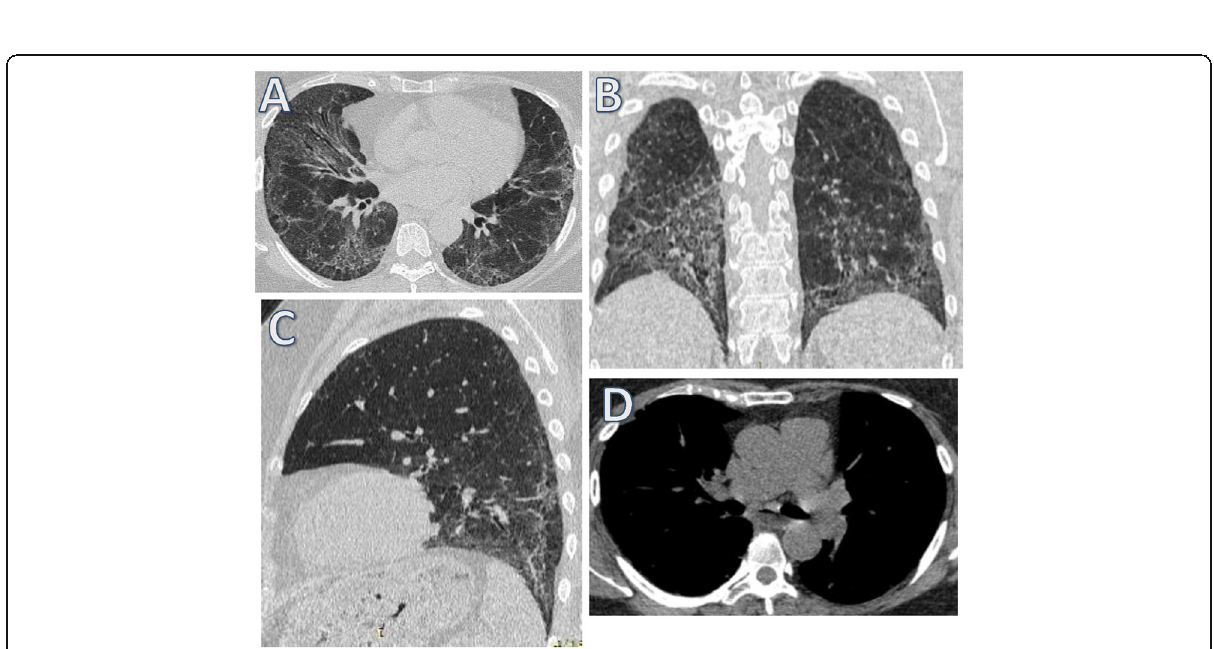
Fig. 3 A 46-year-old female patient diagnosed with systemic sclerosis presenting with progressive dyspnea. a – c Axial, coronal and sagittal reformatted images of HRCT chest (lung window) showing bilateral fairly symmetrical predominantly subpleural with relative sparing of direct subpleural region ground glass opacification, thickening of interlobular and intralobular septae, traction bronchiectasis and bronchiolectasis, and bilateral lower lobar reduced volume. d Axial mediastinal window showing dilated main pulmonary artery denoting pulmonary hypertension and patulous esophagus showing air fluid level; findings impressive of interstitial lung disease (ILD) in the form of non-specific interstitial pneumonia